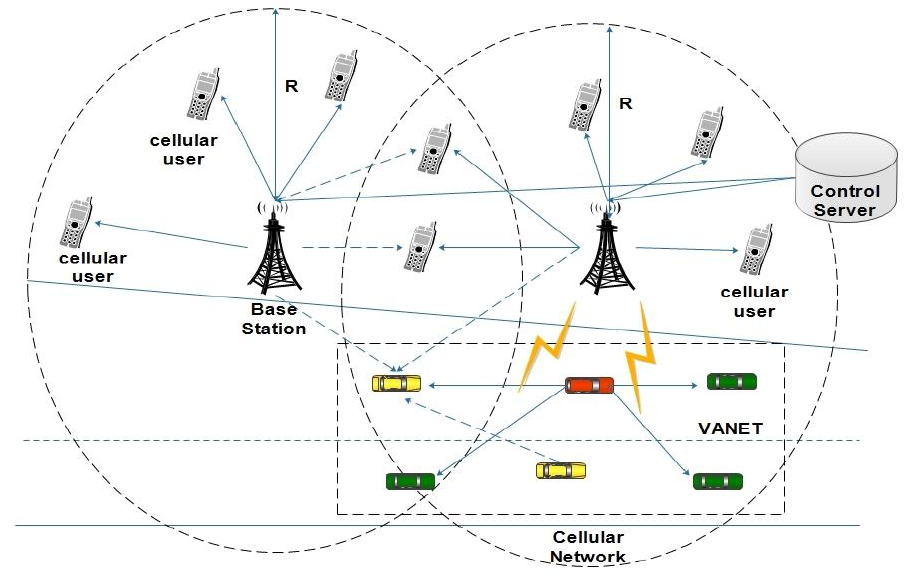
Figure 1. Graphical model for cellular- VANET with divergent